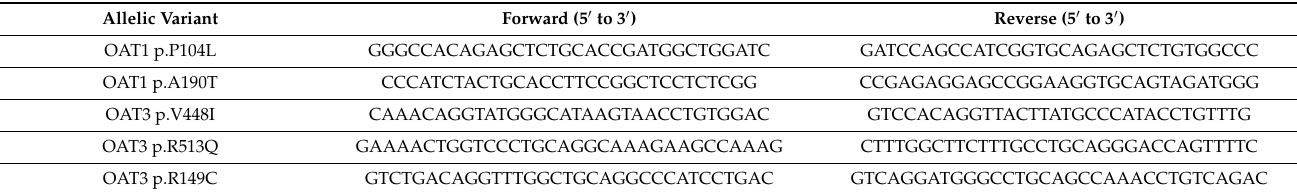
Table 1. Primers for site-directed mutagenesis of allelic variants in OAT1 and OAT3 . Allelic Variant Forward (5 (cid:48) to 3 (cid:48) ) Reverse (5 (cid:48) to 3 (cid:48)